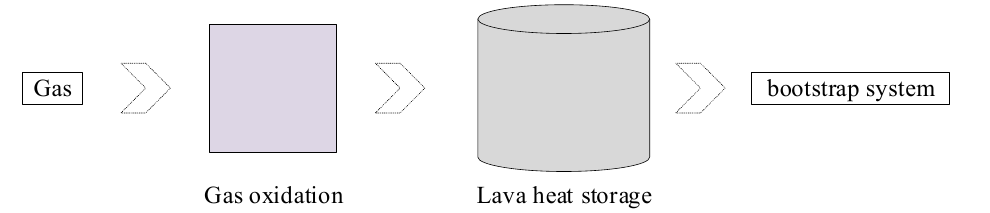
Figure 11. Low-concentration gas utilization system.